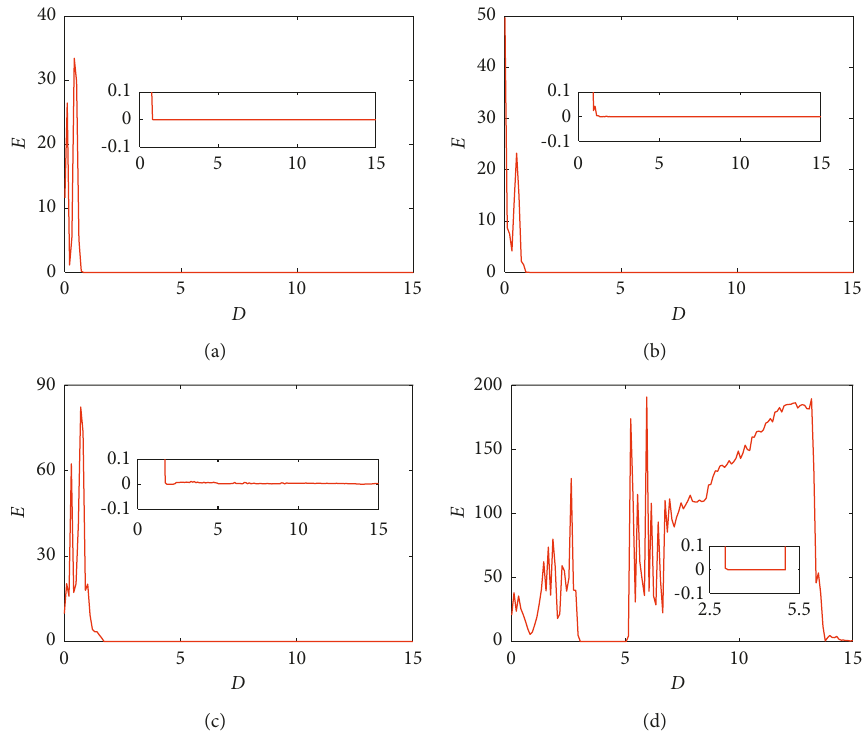
Figure 13: The synchronization errors of the coupled model with respect to coupling strength at case 4 (bursting and spiking neurons). For (a) τ � 0 . 01; (b) τ � 0 . 1; (c) τ � 0 . 5; and (d). τ � 3. Partially enlarged interval for partial synchronization, and the initial values are selected with (0.1, 0.01, 1.05, 0.1, 0.01,